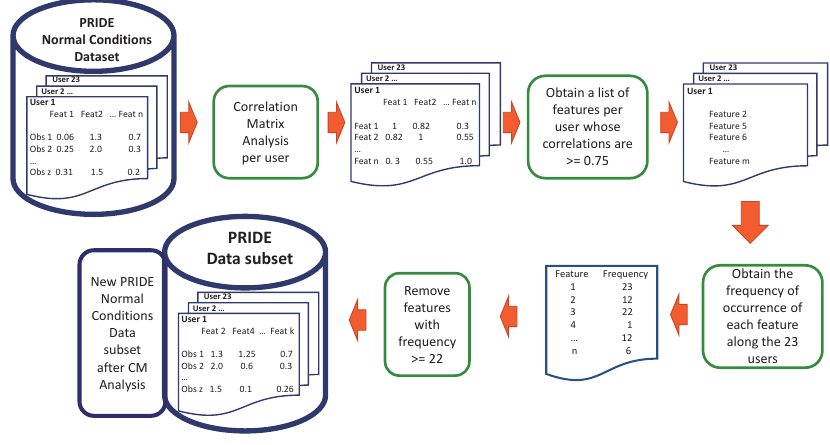
Figure 5. Feature selection process. Phase 1: CM Analysis.